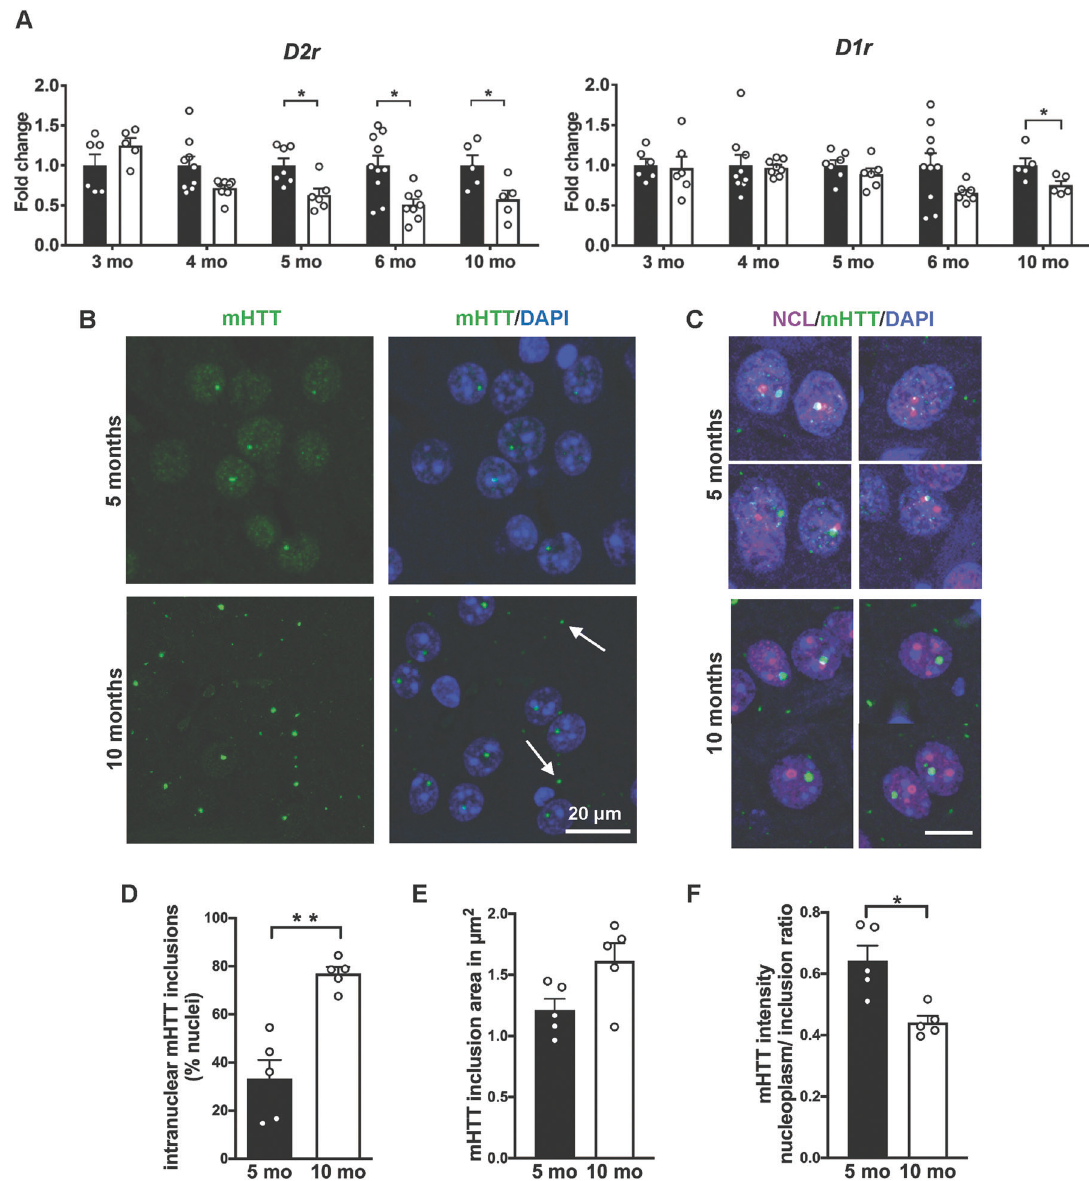
Fig. 3 mHTT nuclear distribution changes at different stages in the striatum of zQ175 knock-in model. A Relative expression of D2r and D1r mRNA in the striatum by qRT-PCR at 3, 4, 5, 6 and 10 months (mo) in control (N = 6, 8, 7, 10, 5) and zQ175 mutant (N = 6, 8, 6, 8, 5) mice is expressed as fold change to the respective controls. Signi fi cantly decreased relative expression of D2r at 5 ( p = 0.014), 6 ( p = 0.012), and 10 months ( p = 0.032) and of D1r at 10 months ( p = 0.032) by Mann – Whitney U test. B , C Representative confocal images of striatal sections from zQ175 mice at 5 and 10 months stained with antibodies against mHTT (EM48) and counterstained with DAPI to visualize the nuclei, and with antibodies against mHTT (EM48) and NCL. Scale bar: 20 µm ( B ), 10 µm ( C ). D Quanti fi cation of the nuclei with mHTT inclusion bodies in the zQ175 mice at 5 and 10 months shows a signi fi cant increase at 10 months by Mann – Whitney U test ( p = 0.008). E Nonsigni fi cant statistical differences in the mean area of the mHTT inclusion signal by Mann – Whitney U test ( p = 0.09) between zQ175 mice at 5 and 10 months. F Nuclear distribution of mHTT is measured as the ratio between mHTT mean intensity in the nucleoplasm and in the nuclear inclusions at 5 and 10 months. mHTT intensity in the nucleoplasm at 10 months is signi fi cantly lower by Mann – Whitney U test ( p = 0.016). N: number of mice = 5; values represent mean values and error bars are SEM. * p < 0.05, ** p < 0.01. represents a histopathological marker of HD progression, we In summary, our results from striatal neurons in different models analyzed skeletal muscle (quadriceps) of controls and zQ175 mice of HD identify nucleolar stress as a mechanism exacerbating at 5 and 10 months (Fig. 5A – C). At 5 months the number of DAPI disease progression, and NPM1 redistribution as a marker for positive nuclei showing either NPM1 or NCL signal was similar disease progression and mHTT aggregation. between zQ175 and control mice (Fig. 5B). The area of the nuclei was also similar between control and zQ175 mutant mice at 5 and Reduced nucleolar localization of NPM1 in skeletal muscle of 10 months (Fig. S7A, B). However, in 10-month-old zQ175 mice, zQ175 mice the nuclear area displaying NPM1 immunosignal was about 30% To explore the hypothesis that perturbed nucleolar homeostasis decreased (Fig. 5C). Importantly, this reduction was speci fi c, as it detected in the striatum by NPM1 nucleolar mislocalization Cell Death and Disease (2021)